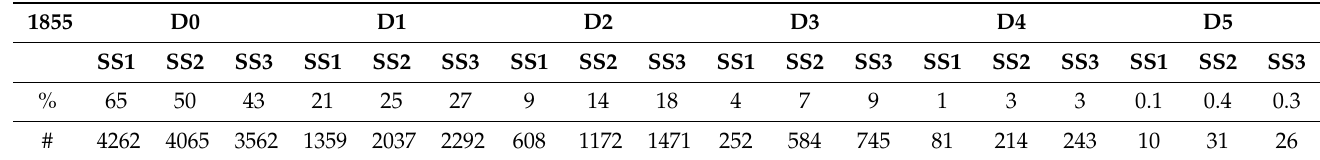
Table 7. Percentage and number of residential buildings per damage level per scale scenario and the corresponding ground motion shown in Figure 8, for the earthquake event of